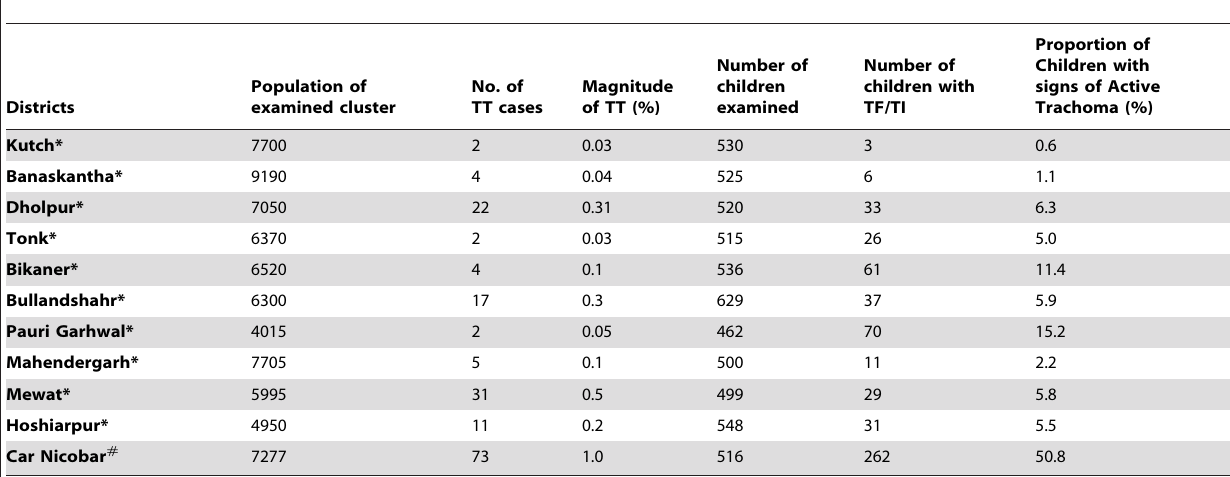
Table 3. Comparative data on magnitude of active trachoma and trachomatous trichiasis in districts covered during 2006 and 2010 NPCB, India trachoma rapid assessment